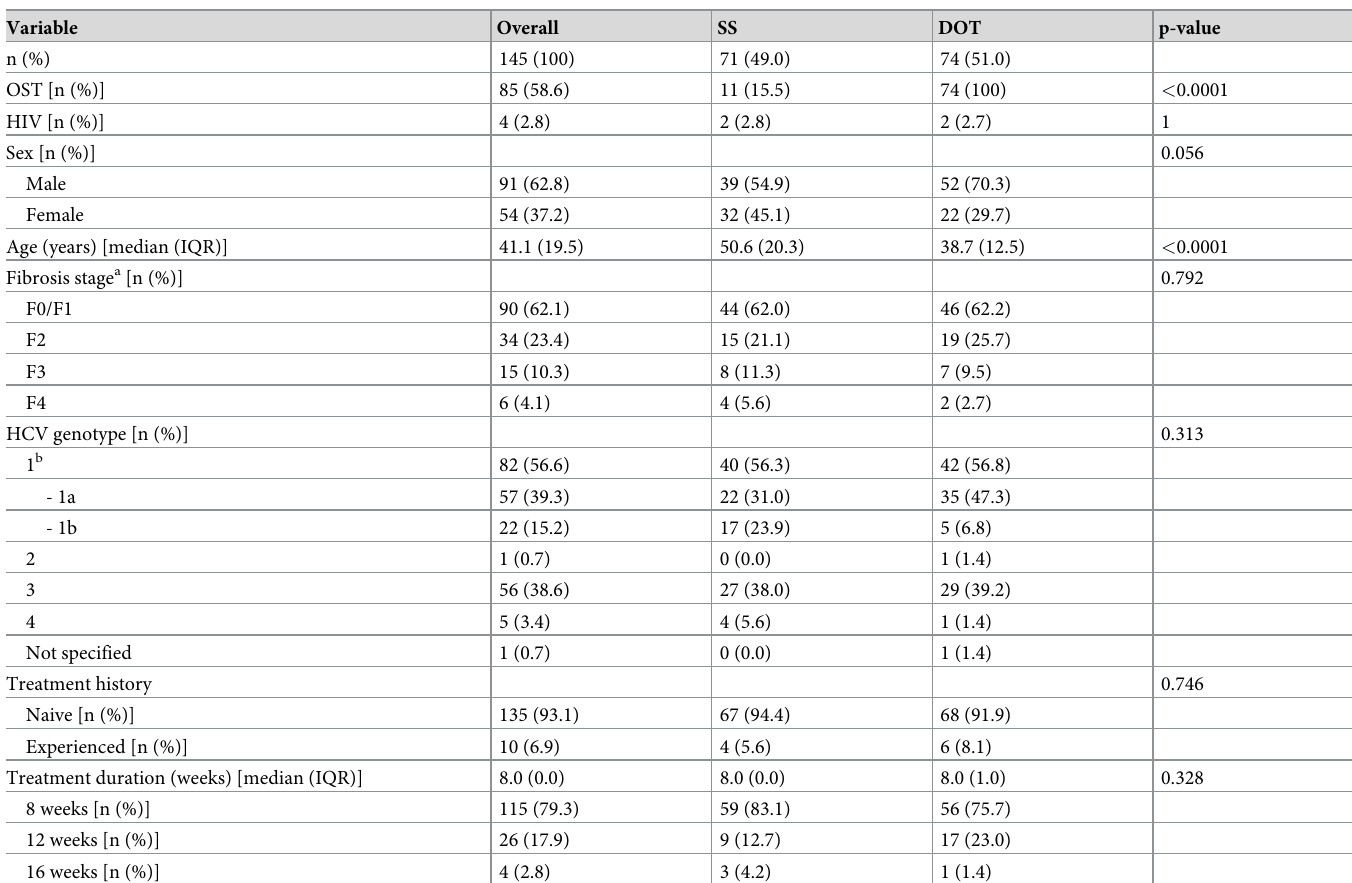
Table 1. Baseline